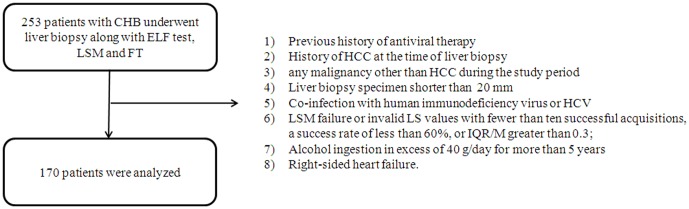
Flow chart describing the selection of the study population.Based on the exclusion criteria, 170 subjects were finally recruited for analyses.